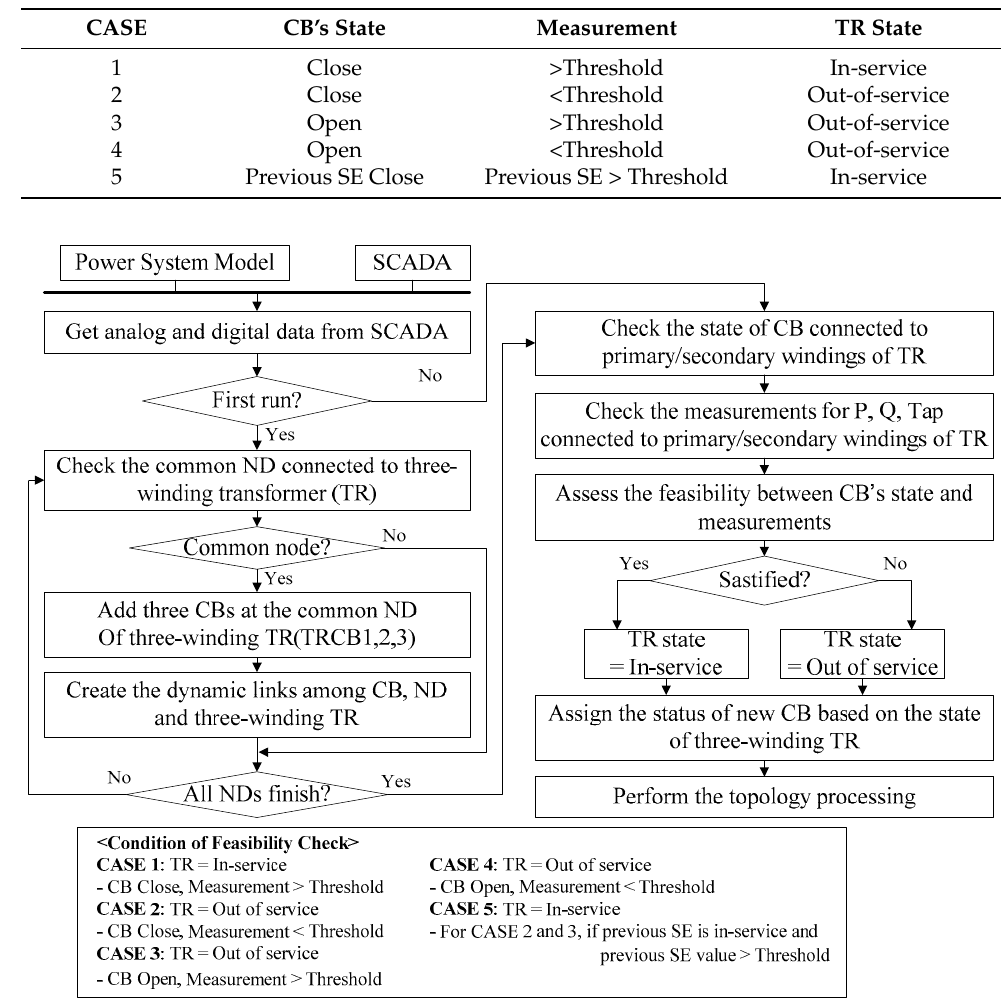
Table 2. Conditions of feasibility check for three winding transformer.